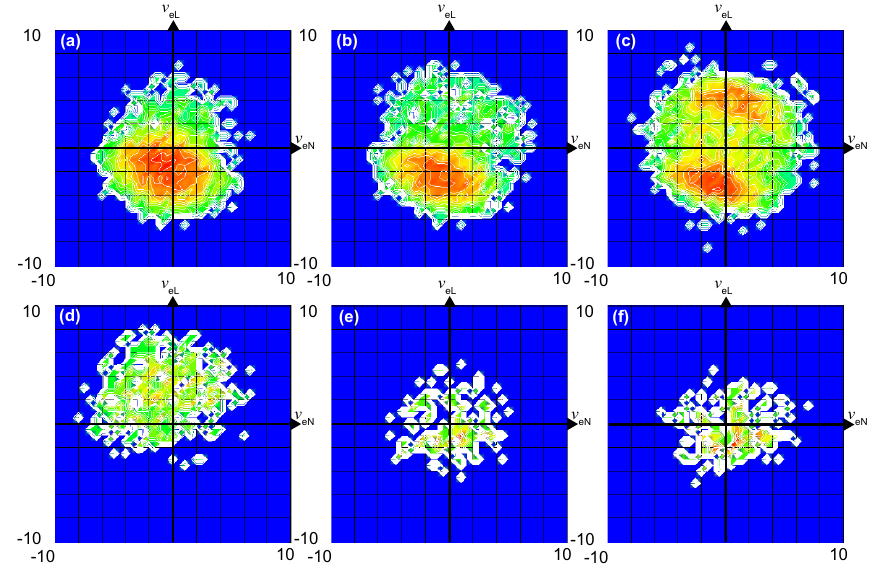
Figure 6 Fig. 6. Electron distribution functions at t =17 and at x L =17.625. Electrons are sampled at (a) x N =1.53 (the negative peak of V eL on the MSH side), (b) x N =1.25 (the n e dip on the MSH side), (c) x N =1.44 (the positive peak of V eL on the MSH side), (d) x N = − 1.5 (the positive peak of V eL on the MSP side), (e) x N = − 1.67 (the n e dip on the MSP side), and (f) x N = − 1.75 (the negative peak of V eL on the MSP side), respectively. The horizontal and vertical axes are the v eN and v eL